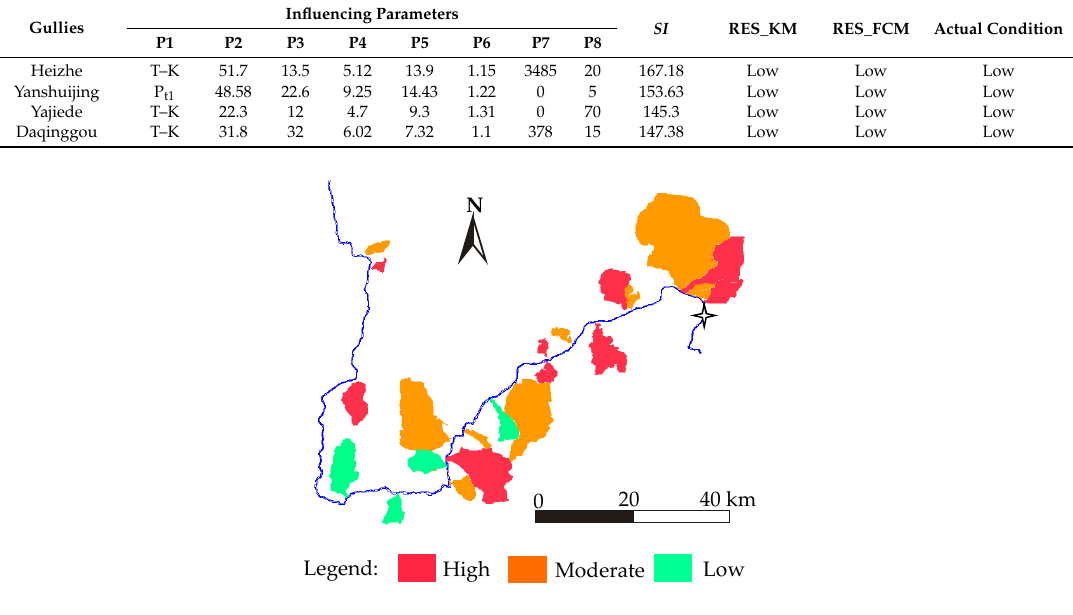
Figure 9. Debris flow susceptibility map.